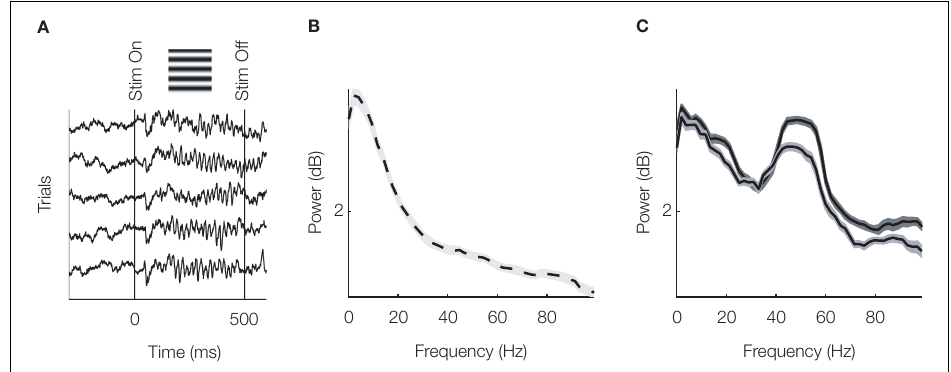
Figure 2 | (A) Exemplar raw traces showing the LFP during a typical trial. Before the onset of stimulation, low frequency fl uctuations dominate the LFP. During stimulation with an oriented grating, however, strong gamma-oscillations are visible. (B) Typical power spectrum of the LFP during the resting state. Low frequency fl uctuations dominate the spectrum, which follows roughly a 1/f decay. (C) Typical power spectra of the LFP during visual stimulation with two gratings of different orientation (differing colours). A pronounced power increase in the gamma-band is observed. In particular, this increase depends in strength on the orientation of the visual stimulus. All displays in this fi gure were adapted from (Berens et al.,